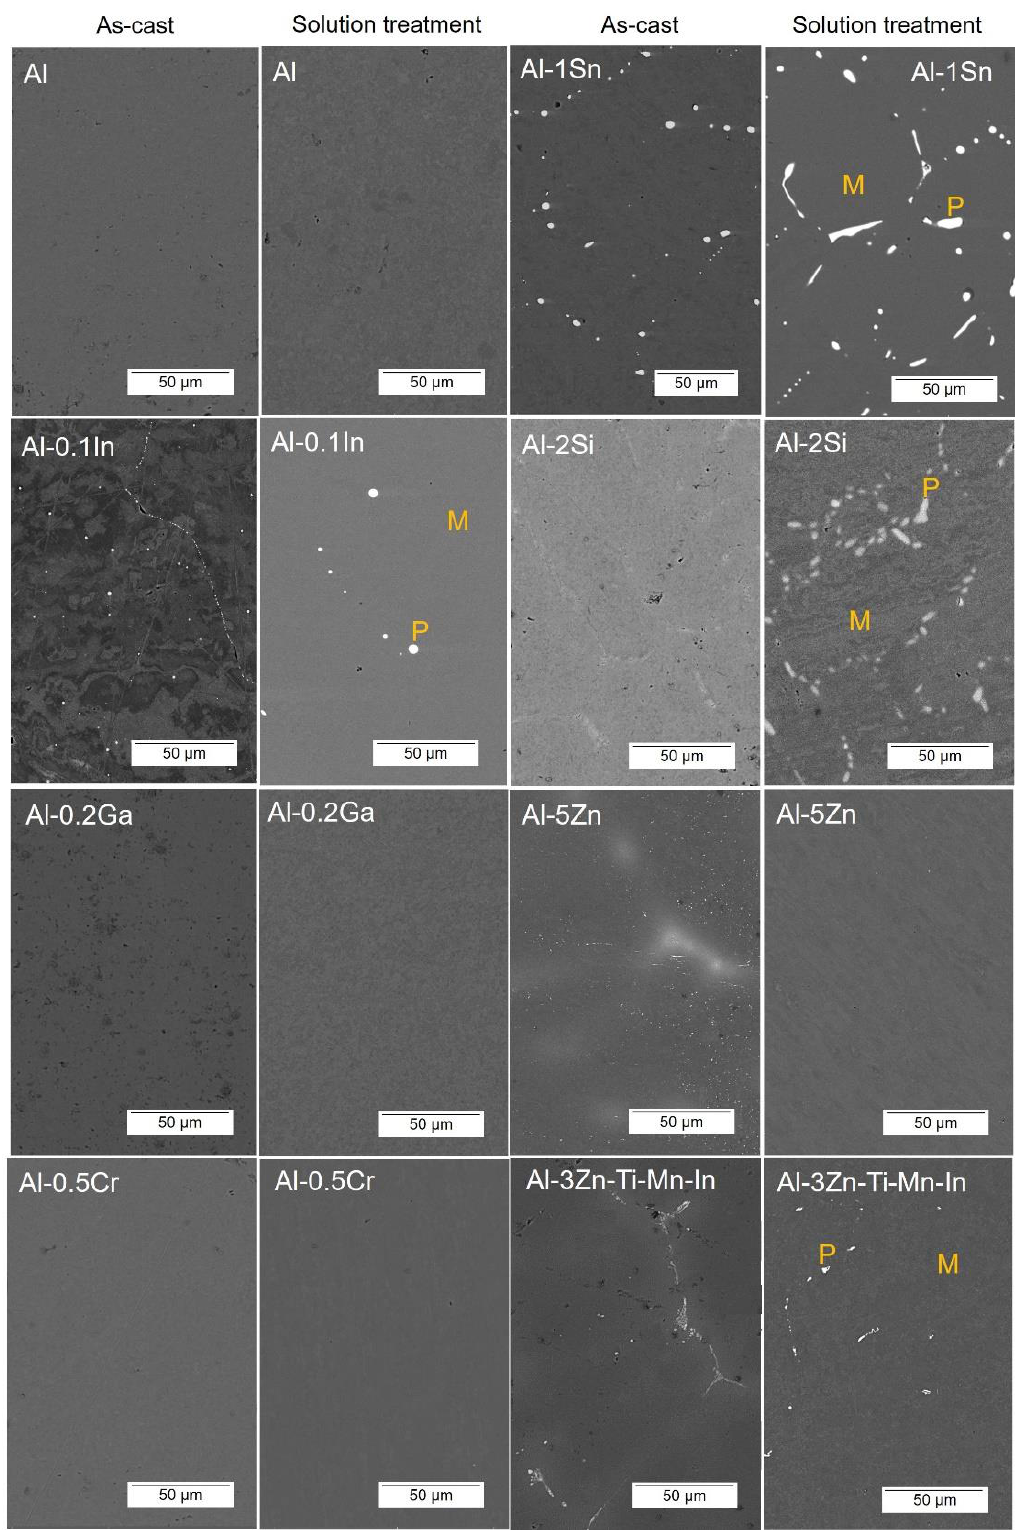
Figure 4. SEM images in the backscattered electron (BSE) mode of as-cast and solution treated Al-based alloys, EDS analysis was carried out in the intermetallic phases labelled as (P) and matrix (M).